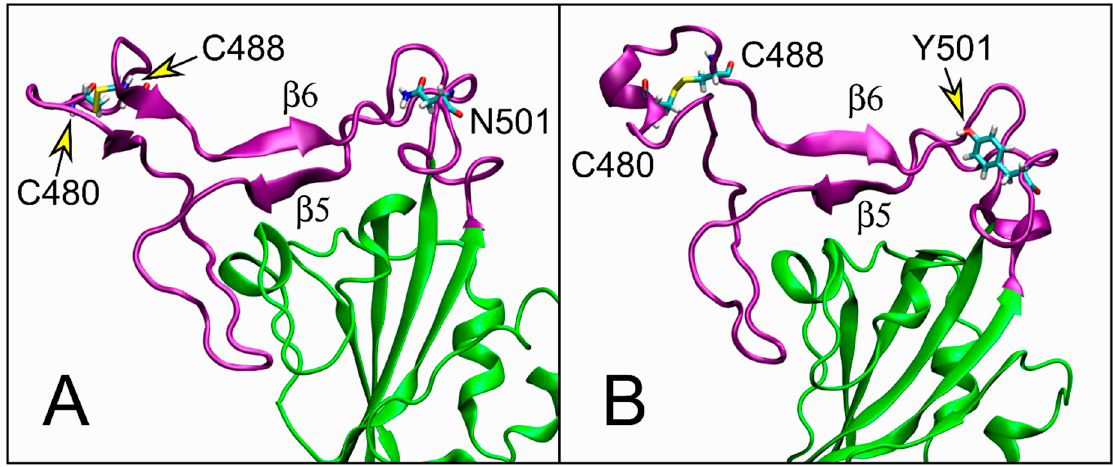
Figure 5. Cartoon representation in the RBM region. ( A ) WT snapshot after 629.8 ns of MD simulation, centroid of the most populated protein cluster. Colors as in Figure 1D–E. Side chains of residues 480, 488, and 501 are shown in licorice view. ( B ) UK snapshot after 840.5 ns of MD simulation, centroid of the most populated protein cluster.